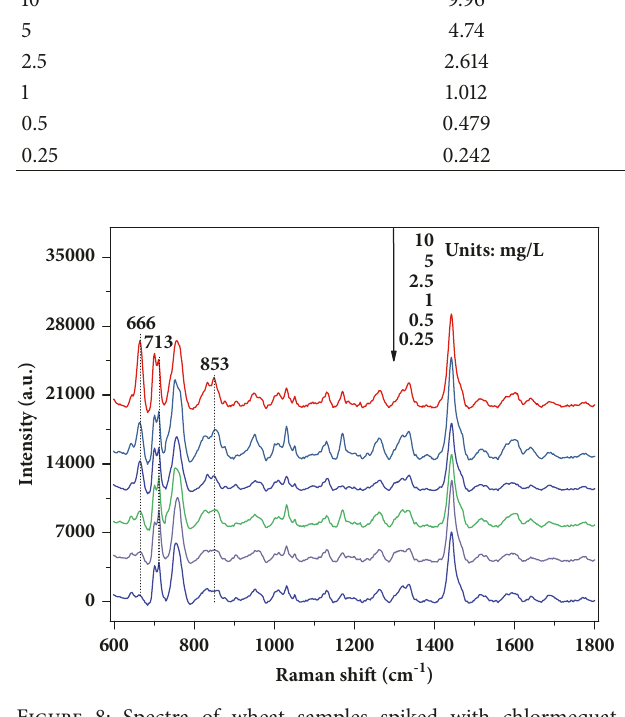
Figure 8: Spectra of wheat samples spiked with chlormequat chloride at 10, 5, 2.5, 1, 0.5, or 0.25 𝜇